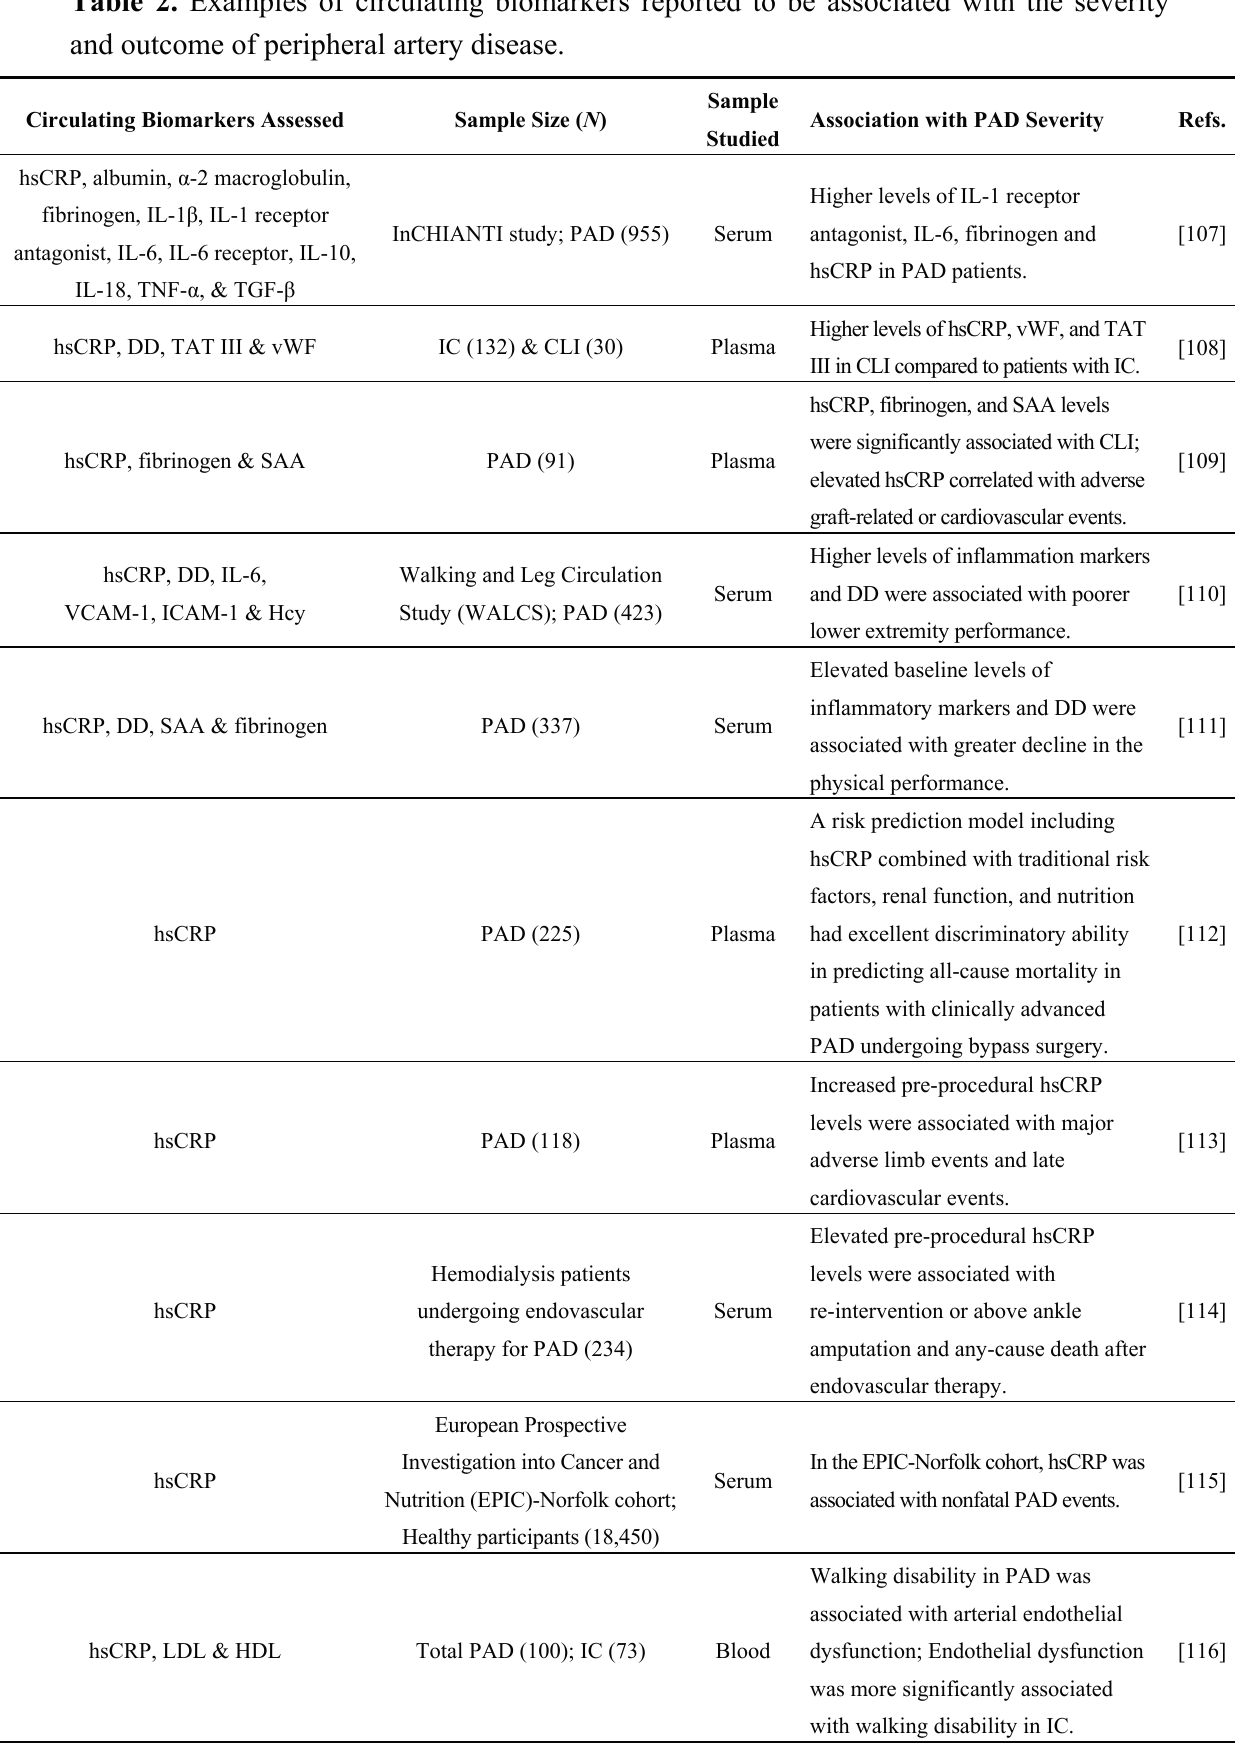
Table 2. Examples of circulating biomarkers reported to be associated with the severity and outcome of peripheral artery